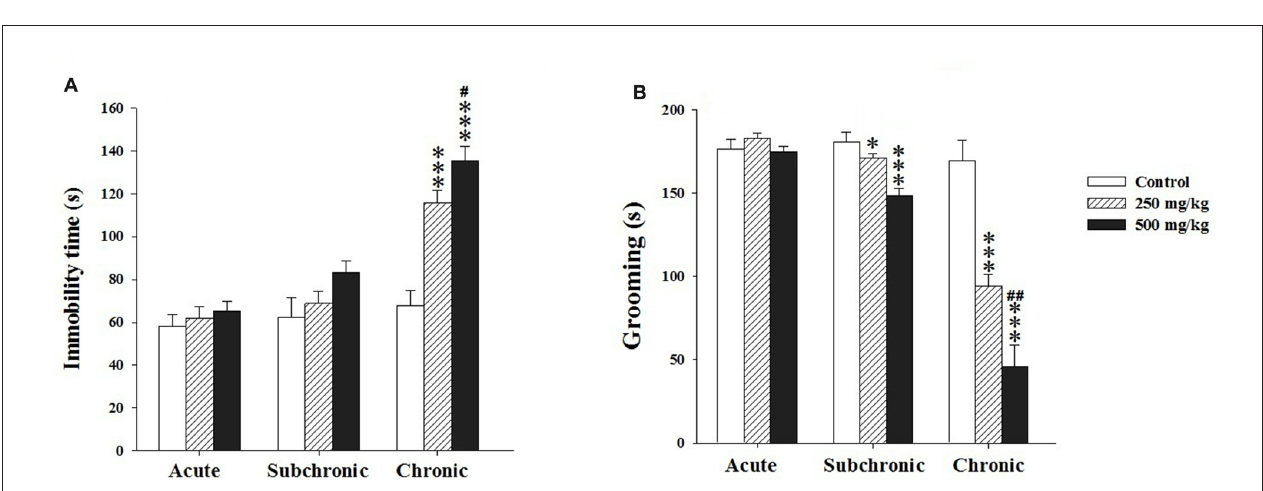
FIGURE 4 | Effect of the acute and repeated exposures to GBH on depression-like behavior. (A) The immobility time in the tail suspension test (TST). (B) The grooming time in the splash test (ST). Results are presented as mean ± SEM. ∗ P < 0.05; ∗∗∗ P < 0.001. The ∗∗∗ refers to the control vs. 250 mg/kg and 500 mg/kg group comparison and the “#” refers to the 250 mg/kg vs. 500 mg/kg group comparison. # P < 0.05, ## P < 0.01: the post hoc